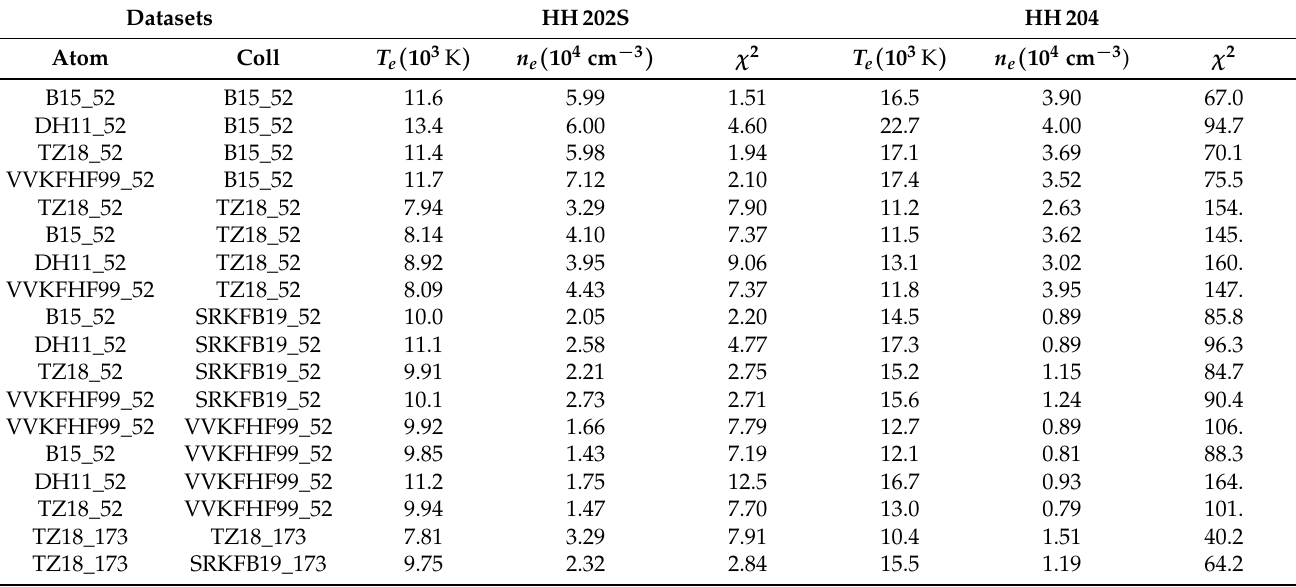
Table 11. Temperature and density fits of the [Fe II ] observed spectra in HH202S and HH204 with the improved and new radiative ( atom ) and collisional ( coll ) datasets.